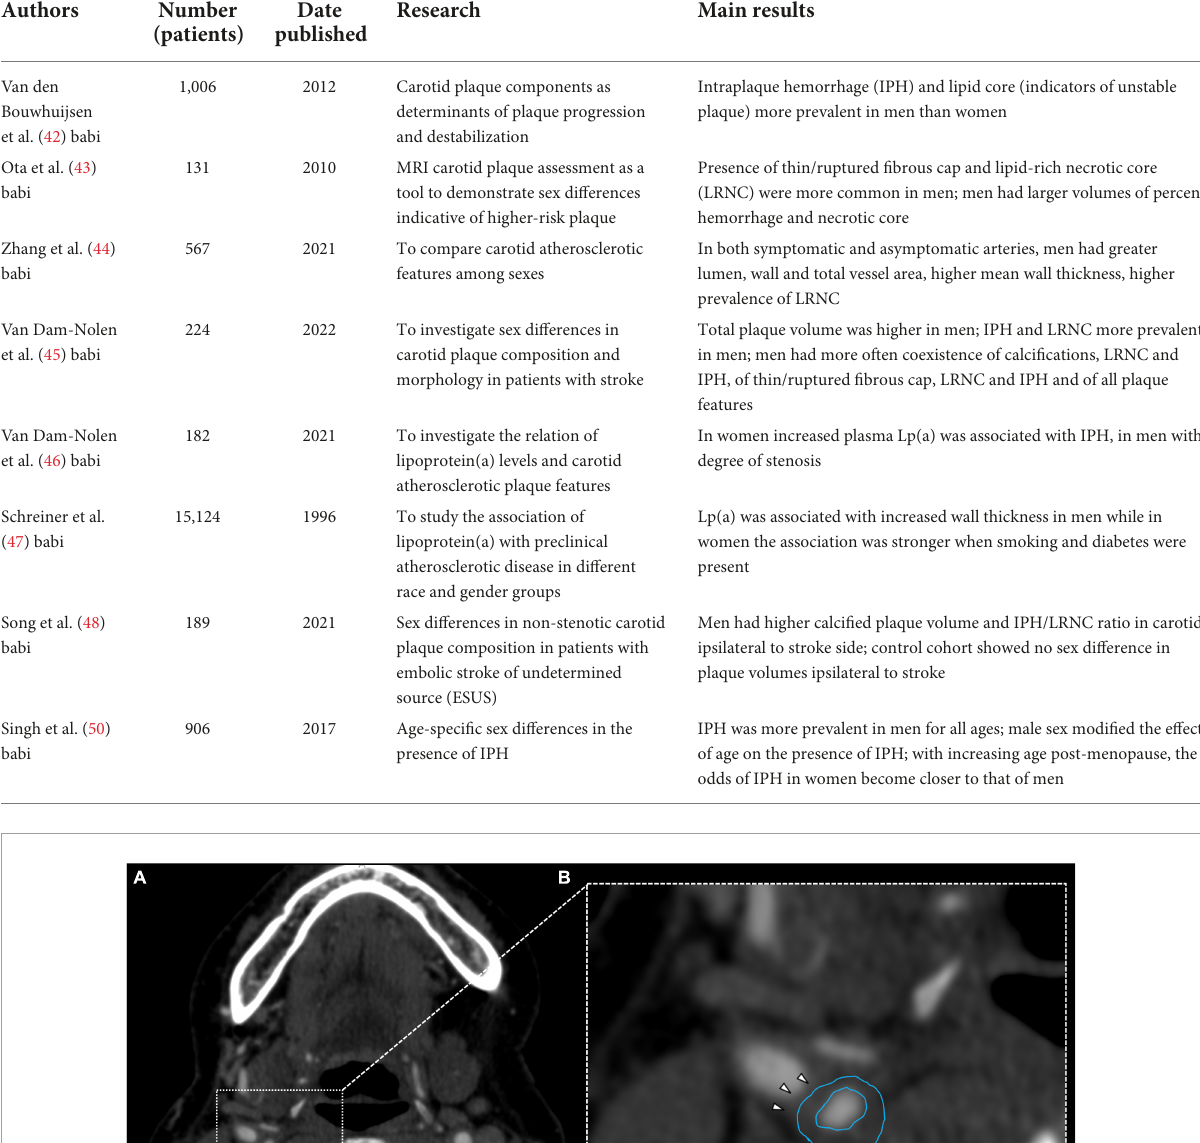
TABLE 2 Studies regarding carotid atherosclerosis.